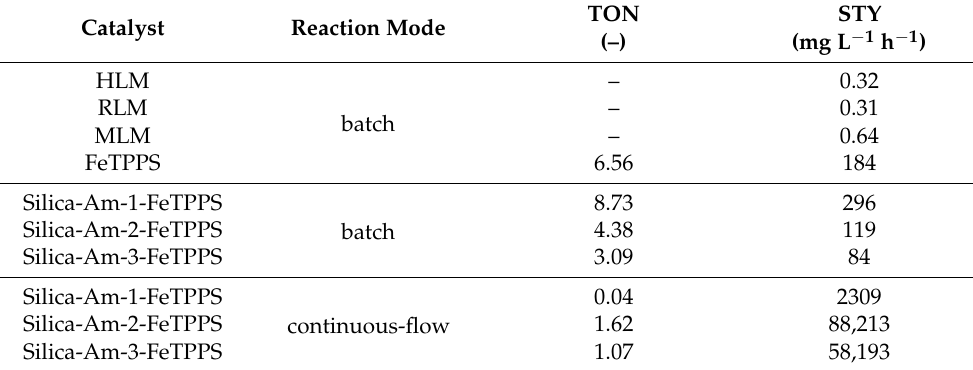
Table 4. Comparison of different liver microsomal (HLM: human liver microsome, RLM: rat liver microsome, MLM: mouse liver microsome) and biomimetic system (dissolved FeTPPS and immobi- lized FeTPPS on silica particles: Silica-Am-1-FeTPPS, Silica-Am-2-FeTPPS and Silica-Am-3-FeTPPS) in the oxidative metabolism of chloroquine based on TON (Turn Over Number) and STY (Space Time Yield)